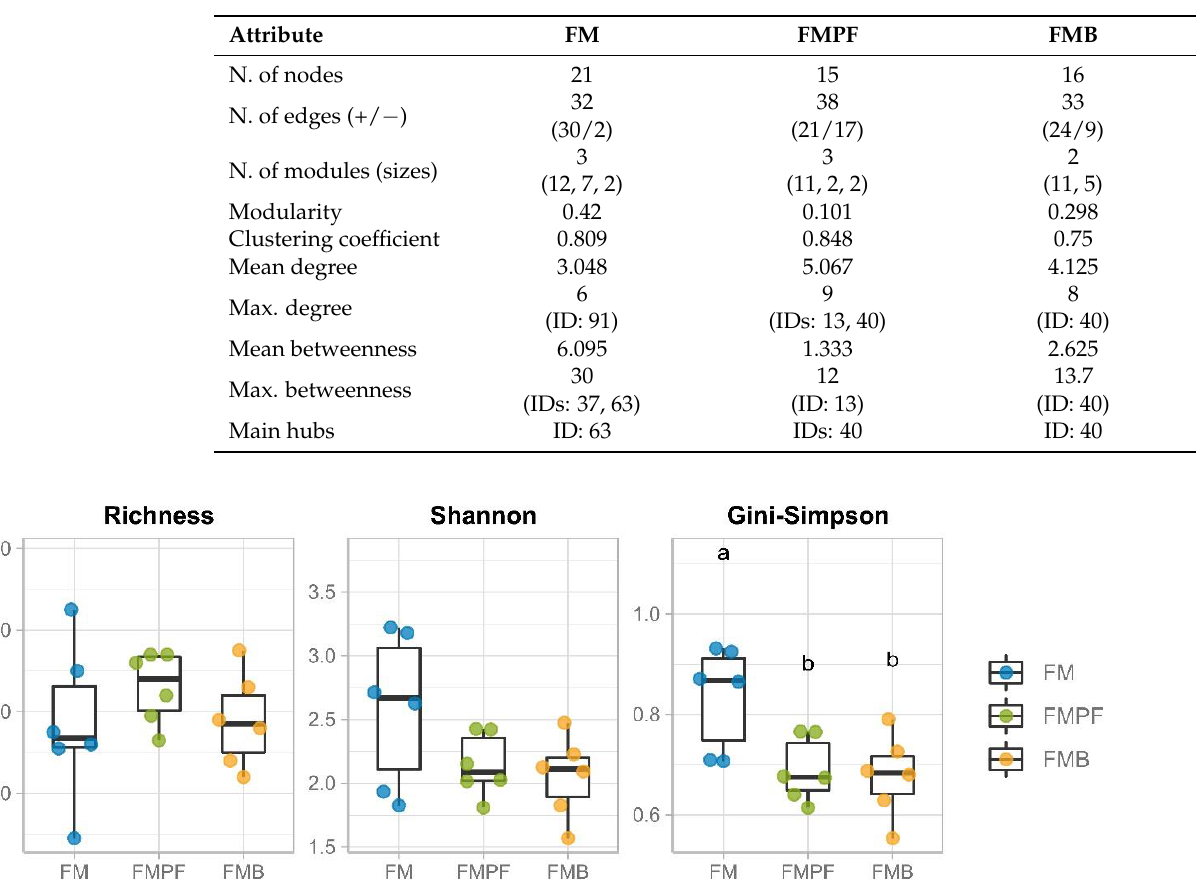
Table 2. Topological characteristics and centrality measures of the co-occurrence networks of the genera present in fermented milk.